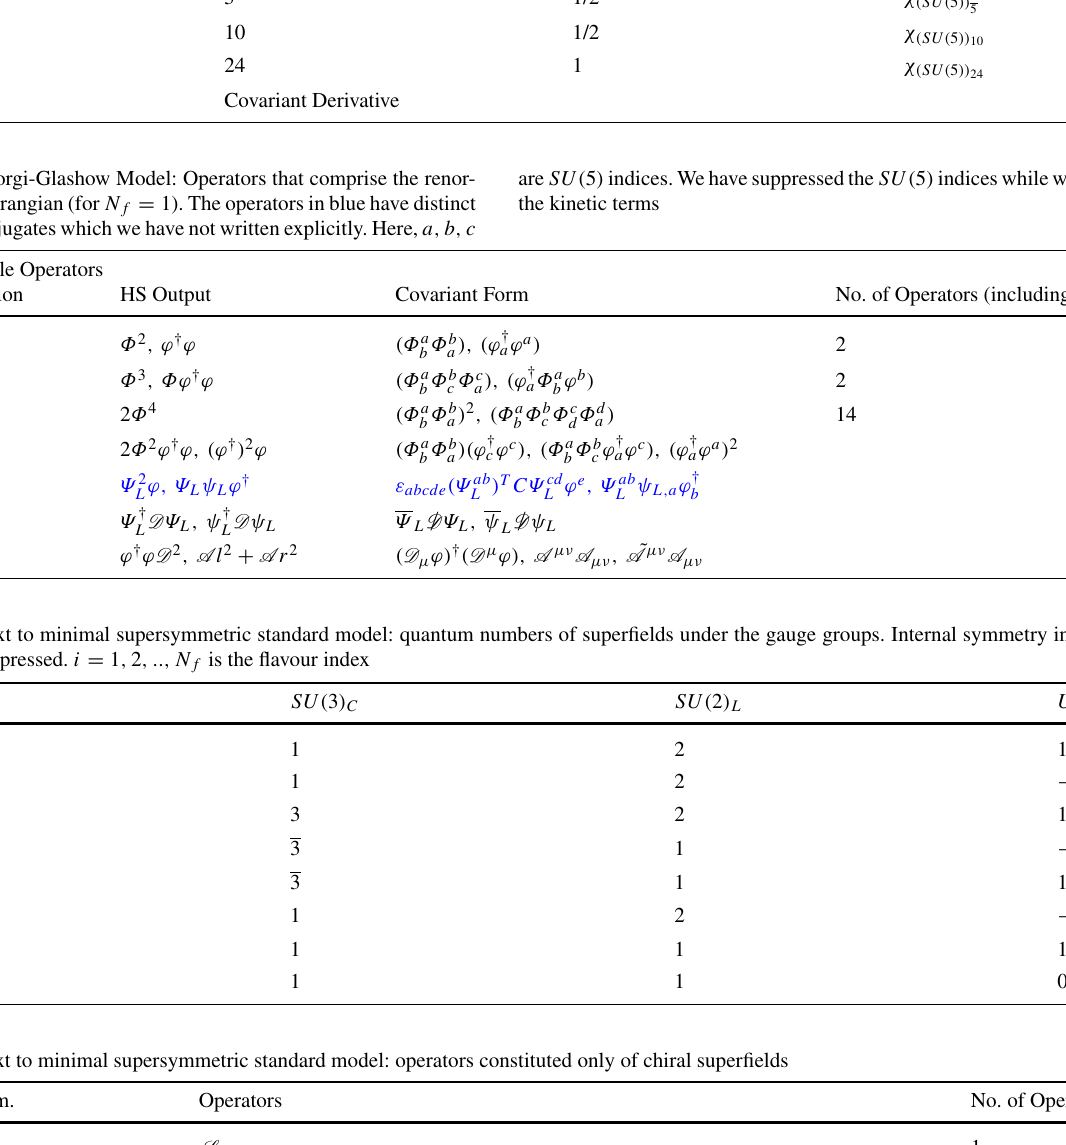
Table 49 SU ( 5 ) GUT: Quantum numbers of fields under the gauge groups, their spins and gauge group characters. Since the model only contains fields with spins-0, -1/2, and -1, the relevant Lorentz charac- Fields